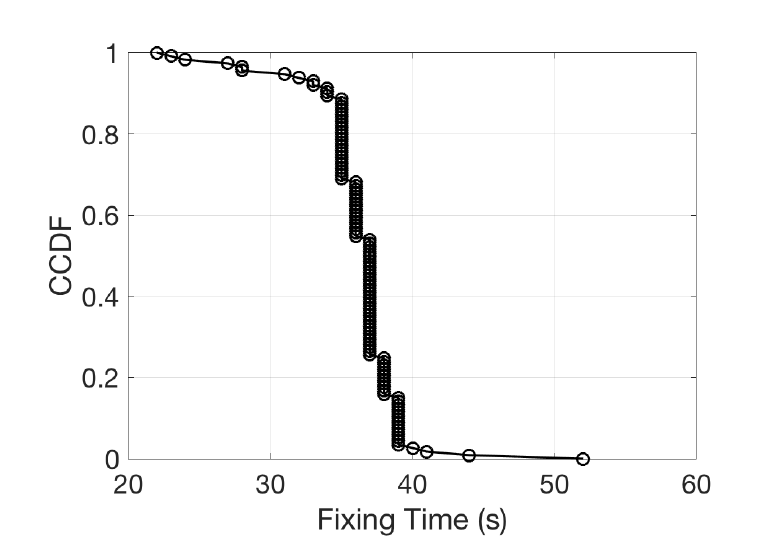
Figure 13. Complementary cumulative distribution function of the time to obtain the first fix from the GPS unit.